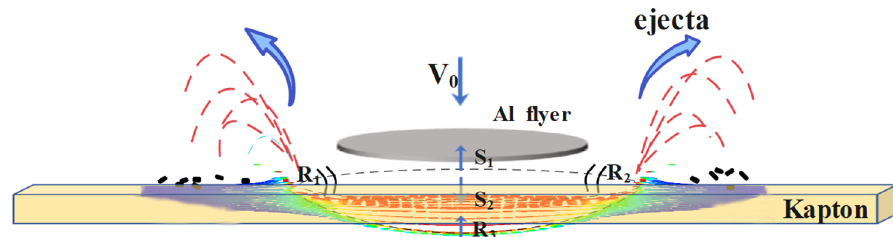
Figure 7. Schematic diagram of debris cloud formation process.